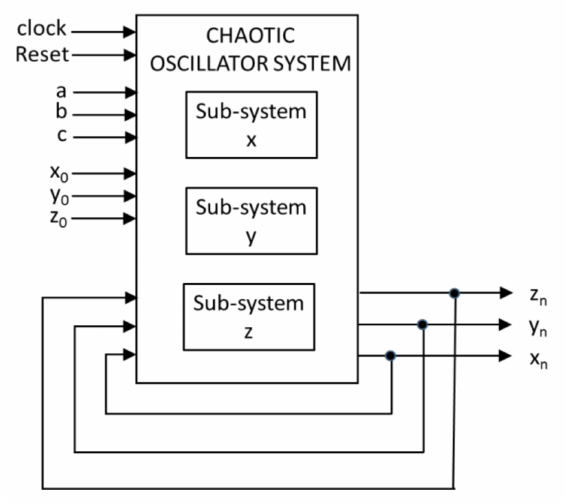
Figure 14. Top-level hardware design of the discretized chaotic oscillator system (9).